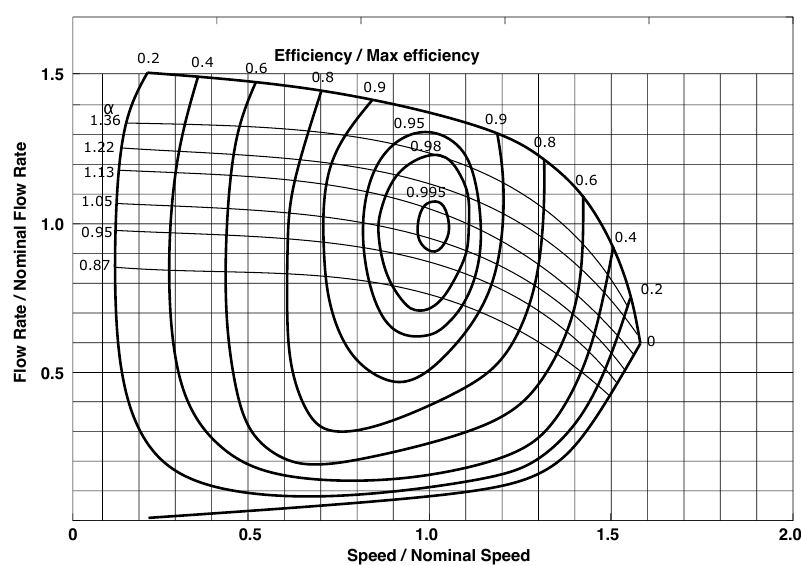
Figure 5. Performance of a slow-Francis turbine by the variation of the relative guide vanes angle α : the speed variation and the flow variation over the their nominal values are on the x-axis and y-axis, respectively.